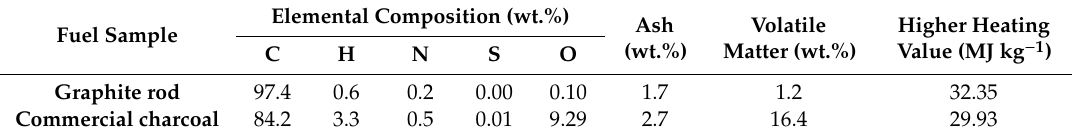
Table 5. The main parameters of the fuels used for MH-DCFC tests (all values are given for a “dry” state).